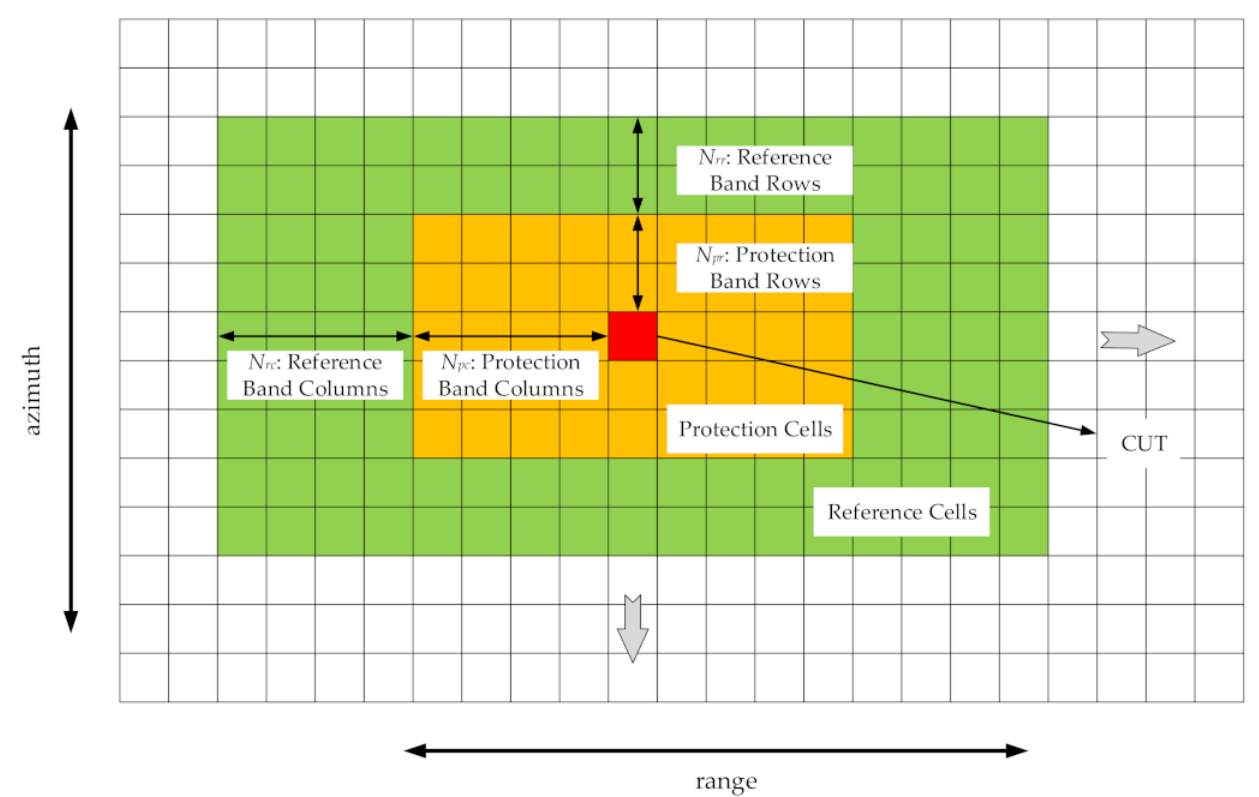
Figure 2. The structure of the two-dimensional sliding reference